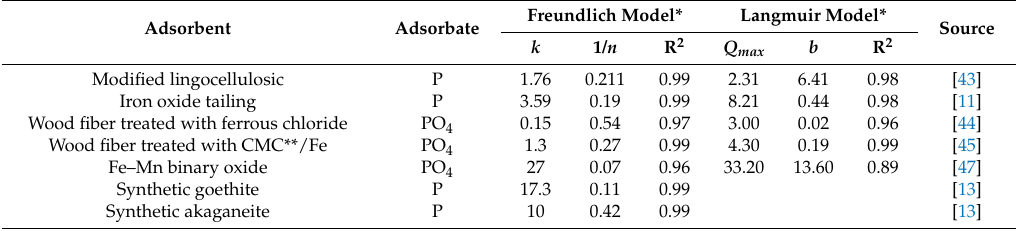
Table 4. Freundlich and Langmuir isotherms constants for phosphate adsorption on adsorbents activated with iron ions. Adsorbent